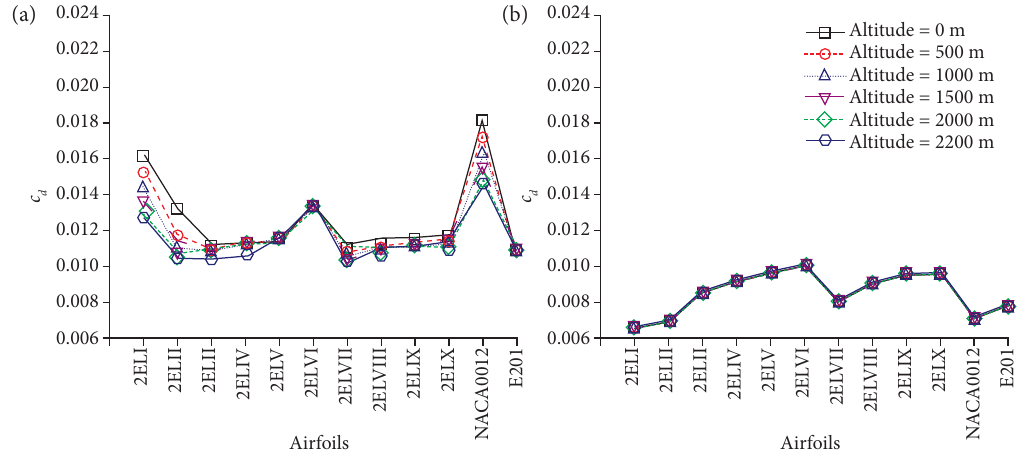
Figure 12. Drag coefficients for required lift coefficients (four-element). (a) Re = 2.5 × 10 5 ; (b) Re = 4.8 × 10 5 .